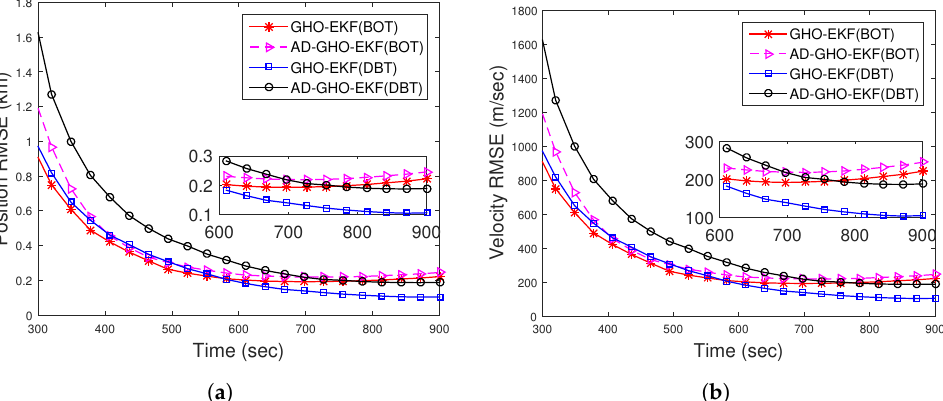
Figure 13. RMSEs of the ( a ) position; ( b ) velocity of the BOT and DBT for Scenario II for unknown fixed R